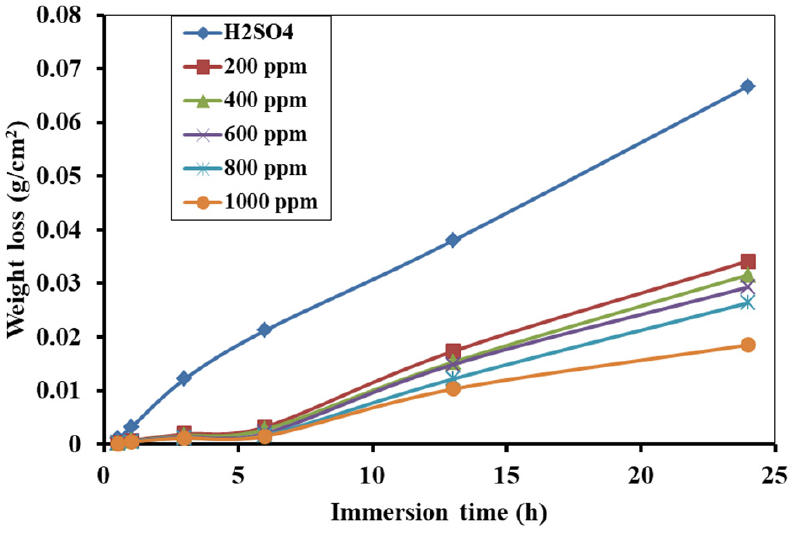
Figure 7. Weight loss of mild steel immersed in different concentrations of ST alkaloids at different intervals of time at 20 ° C.